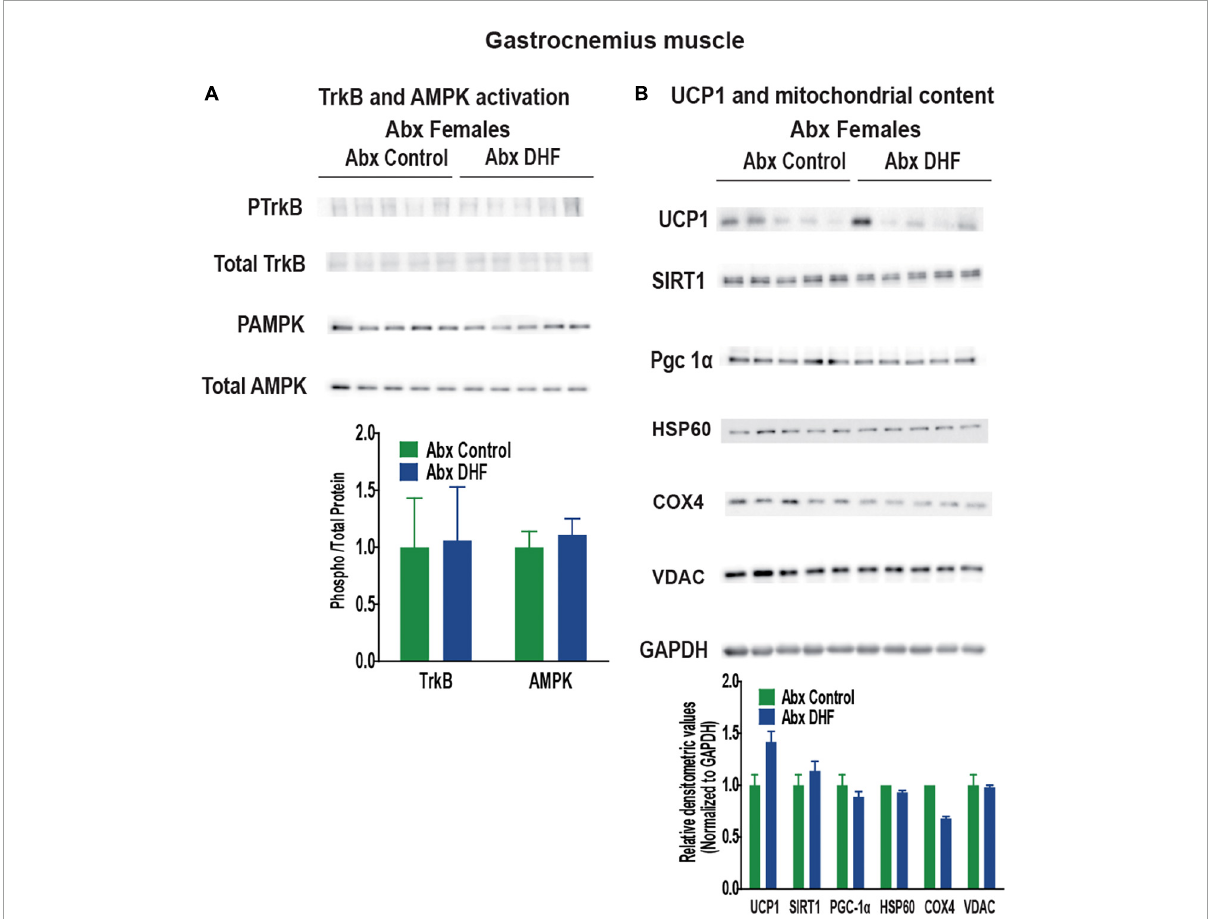
FIGURE7 Gut microbiome ablation prevents UCP1 and TrkB activation by DHF in gastrocnemius tissue of females. (A) Expression and quantification of TrkB and AMPK activation in gastrocnemius tissue. (B) Expression and quantification of mitochondrial content markers in gastrocnemius tissue. Statistical analyses were carried out using student’s t -test. p -values < 0.05 were considered significant. Data are expressed as average ± SEM ( n = 5). * p < 0.05 vs. sex-and treatment-matched